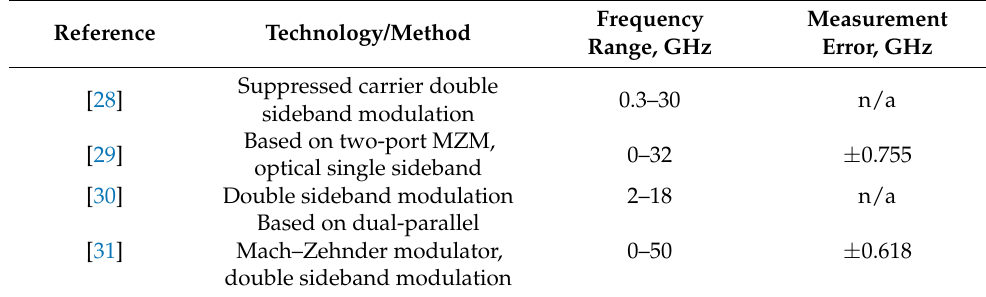
Table 3. Performance of IFM techniques based on